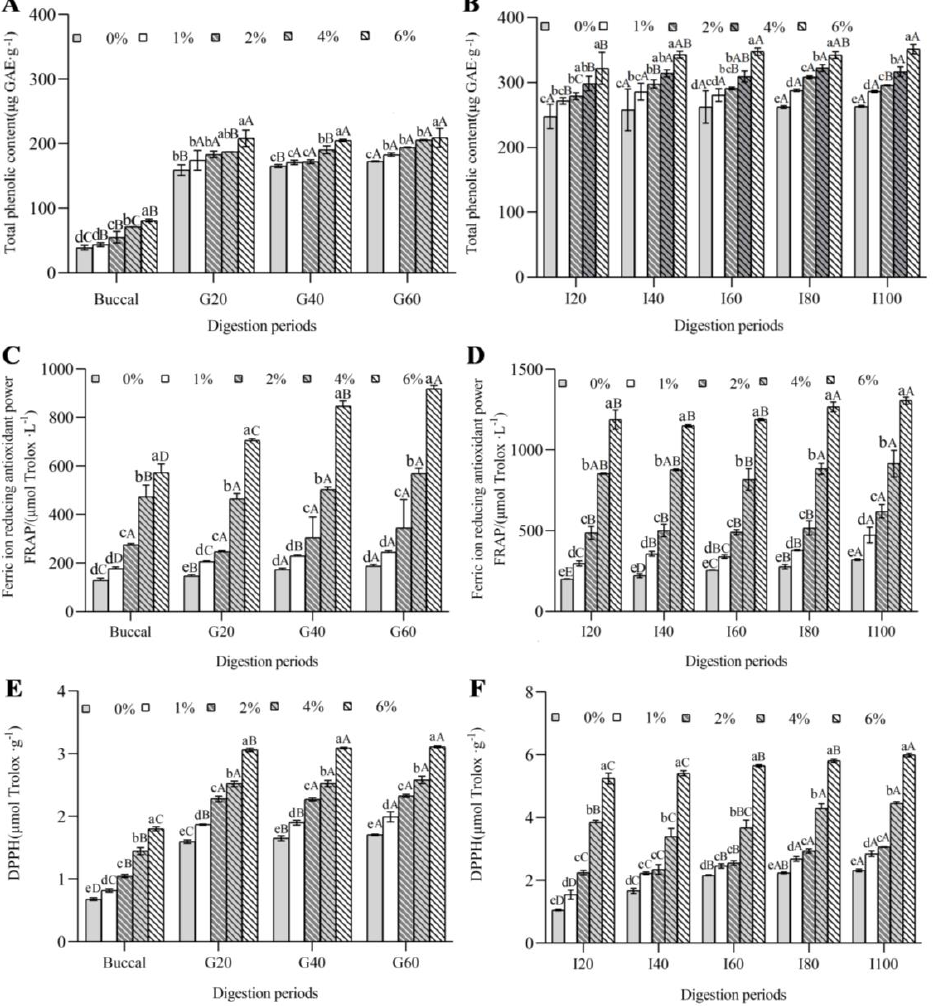
Figure 5. Total phenolic content ( A , B ) and antioxidant activity measured by FRAP ( C , D ) and DPPH ( E , F ) of FGM supplemented with BHJ after in vitro buccal, gastric and intestinal digestion: Buccal digestion refers to the buccal phase for 0.5 minutes; G20, G40 and G60 indicate the gastric phases for 20, 40 and 60 min, respectively; I20, I40, I60, I80 and I100 indicate the intestinal phases lasting 20, 40, 60, 80 and 100 min, respectively. Note: Different lowercase letters denote significant differences ( p < 0.05) between different concentrations of blue honeysuckle juice; different uppercase letters de- note significant differences ( p < 0.05) between different digestion periods.